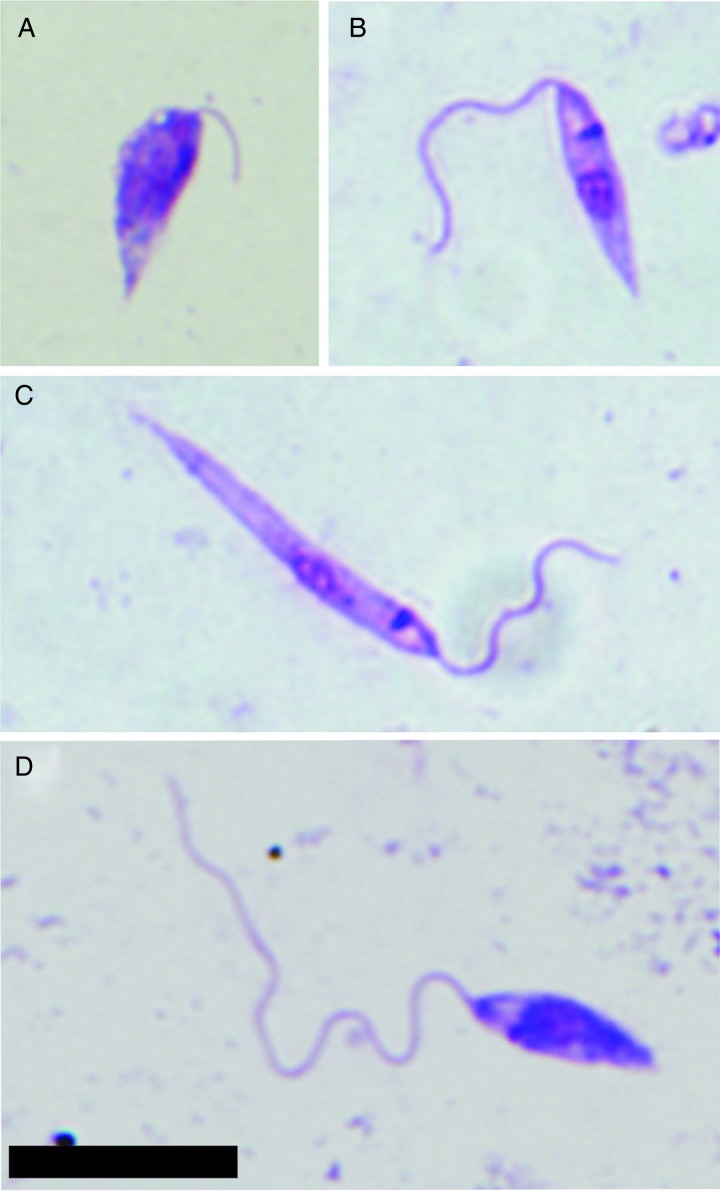
Morphological forms of L. donovani distinguished in this study based on criteria described in the Materials and Methods section. Parasites from midgut smears of infected sand flies were fixed with methanol and stained with Giemsa. (A) Procyclic promastigote; (B) short promastigote; (C) elongated nectomonad; (D) metacyclic promastigote. Scale bar = 10 µm.